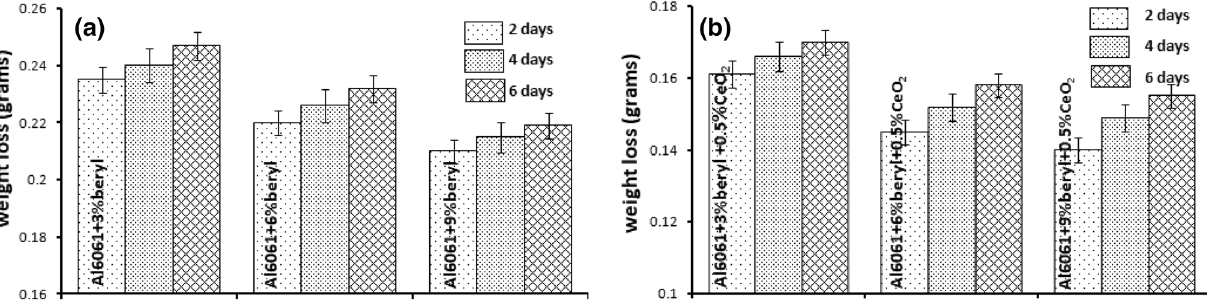
) during sliding of investigated “Al6061–Beryl–CeO d